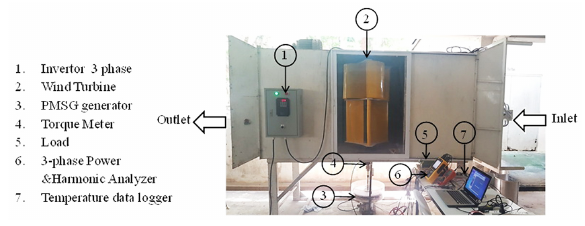
Fig. 2. PMSG wind tunnel testing